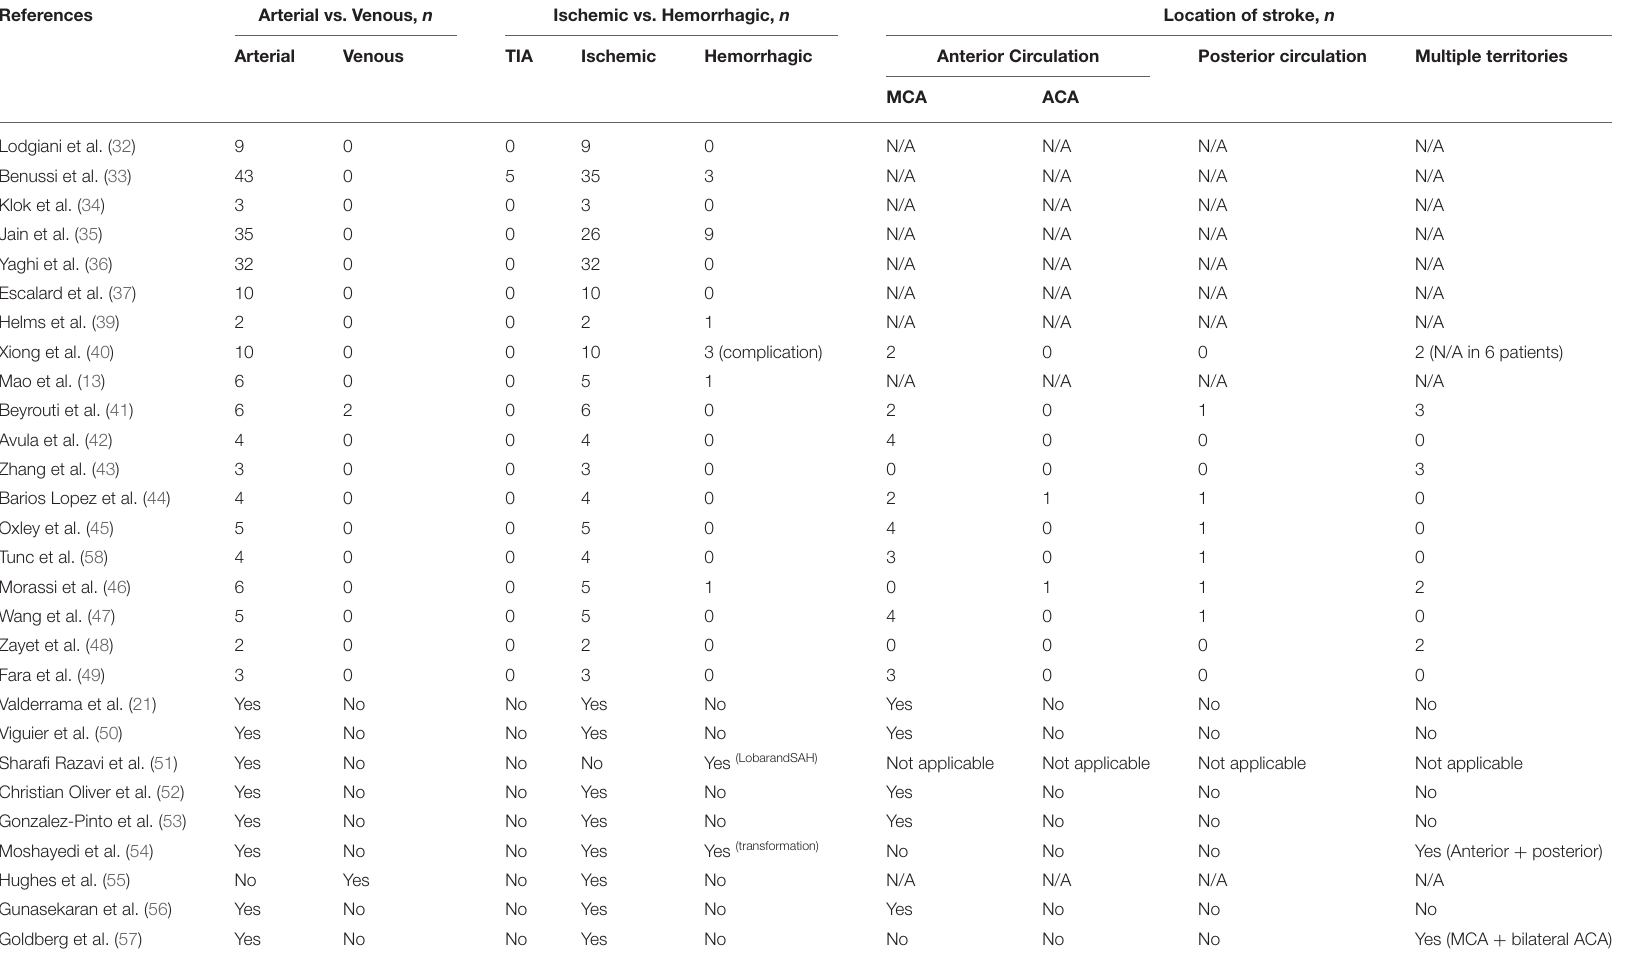
TABLE 3 | Classification of stroke based on imaging findings in COVID-19